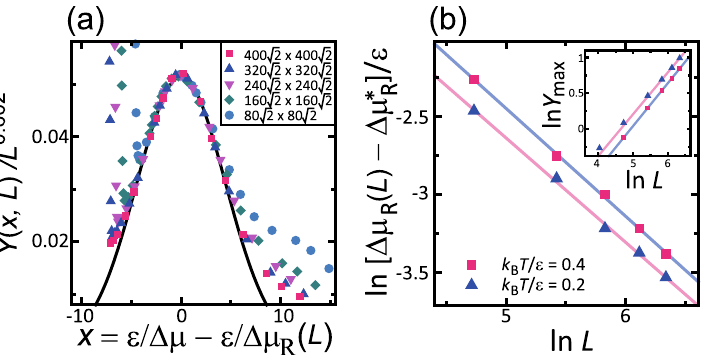
p 3 √ 2 / 8 1 . ( a ) Scaling function for step-disassembly. 0.530. a 0.4 . ǫ int /ǫ 0.9 . Figure 5. k B T /ǫ ¯ = = ≈ = = − Y ( x , L ) follows Eq. (6) with Eqs. (7) and (8). The line follows Eq. (10). ( b ) Log–log plot of the linear system size L and the difference between �µ R and �µ ∗ R , where �µ ∗ R is �µ R in the limit L . Inset: log–log plot of → ∞ Y max and L , where Y max is the value Y (0, L ) (Eqs. (11) and (12)). Blue triangles and pink line: k B T /ǫ 0.2 . Red = 0.4 . squares and light blue line: k B T /ǫ =